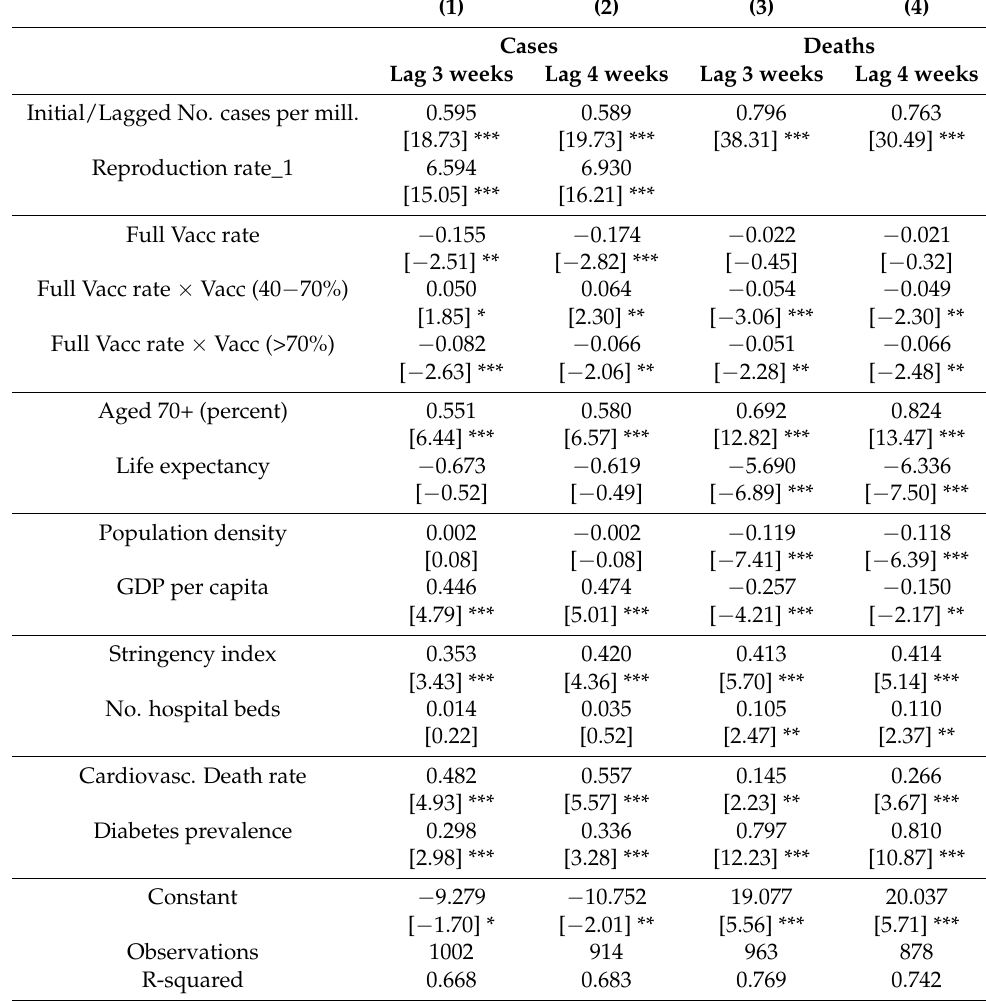
Table A7. Impact of vaccination threshold rate on number of new cases and deaths, all countries.